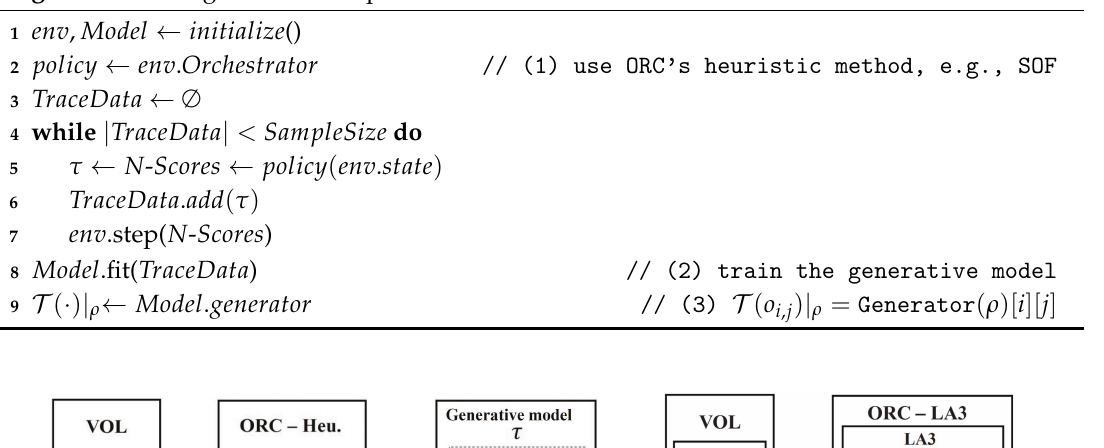
Algorithm 2: LA3 generalization process